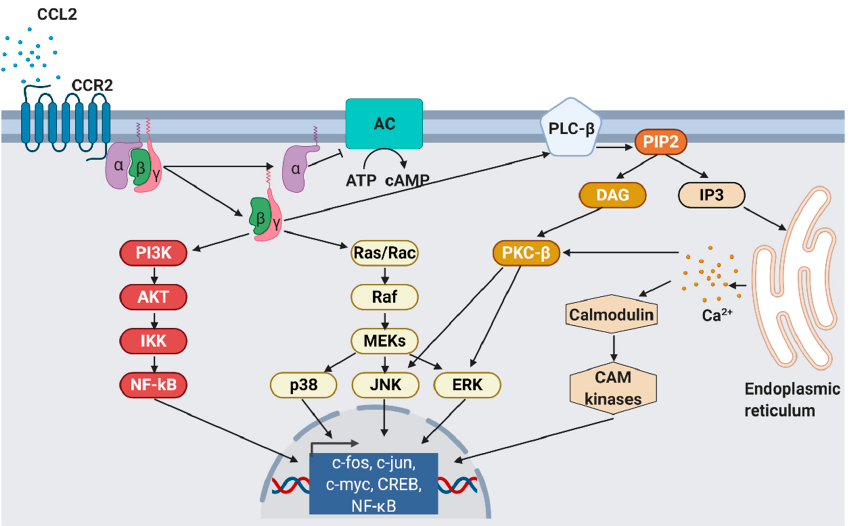
Figure 2. CCL2 signaling. As response to CCL2 binding at the N-terminus, extracellular loops and transmembrane bundle of CCR2, the intracellular G-protein α i subunit dissociates from the CCR2 and the βγ subunit. The α subunit then inhibits adenylyl cyclase (AC) function resulting in decreased cyclic adenosine monophosphate levels. In contrast, the βγ subunit signaling induces gene expression via several pathways. PI3K, phosphoinositide 3-kinase; AKT, protein kinase B; IKK, inhibitor of NF- κ B kinase; NF- κ B, nuclear factor of kappa-light-chain-enhancer of activated B cells; Ras, rat sarcoma; Rac, ras-related C3 botulinum toxin substrate; Raf, rapidly accelerated fibrosarcoma; MEK, mitogen-activated protein kinase; p38, mitogen-activated protein kinase; JNK, c-jun N-terminal kinase; ERK, extracellular signal-regulated kinase; PLC- β , phospholipase C- β ; PIP2, phosphatidylinositol 4,5-bisphosphate; DAG, diacylglycerol; IP3, inositol 1,4,5-triphosphate; PKC- β , protein kinase C- β ; CAM, Ca 2+ /calmodulin-dependent protein kinase; c-fos, proto-oncogene c-Fos; c-jun, proto-oncogene Jun; c-myc, proto-oncogene Myc; CREB, cAMP response element-binding protein. Modified from Bose S. & Cho J. [75] using